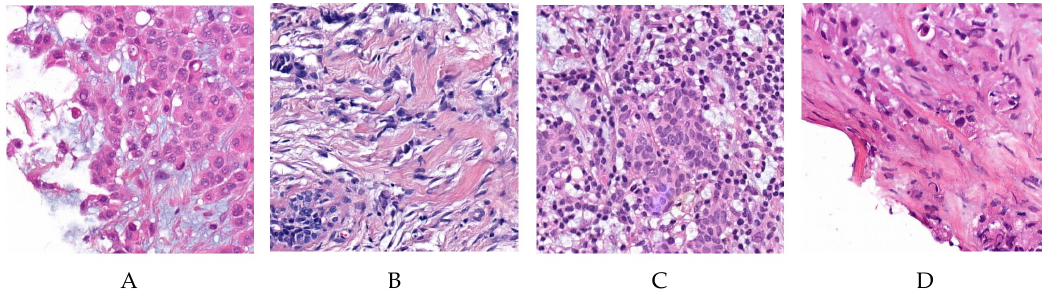
Figure 6. Tiles identified by the HER2 classifier as positive (first two tiles, tile ( A ) is a true positive, tile ( B ) is a false positive), and negative (last two tiles, tile ( C ) is a true negative, and tile ( D ) is a false